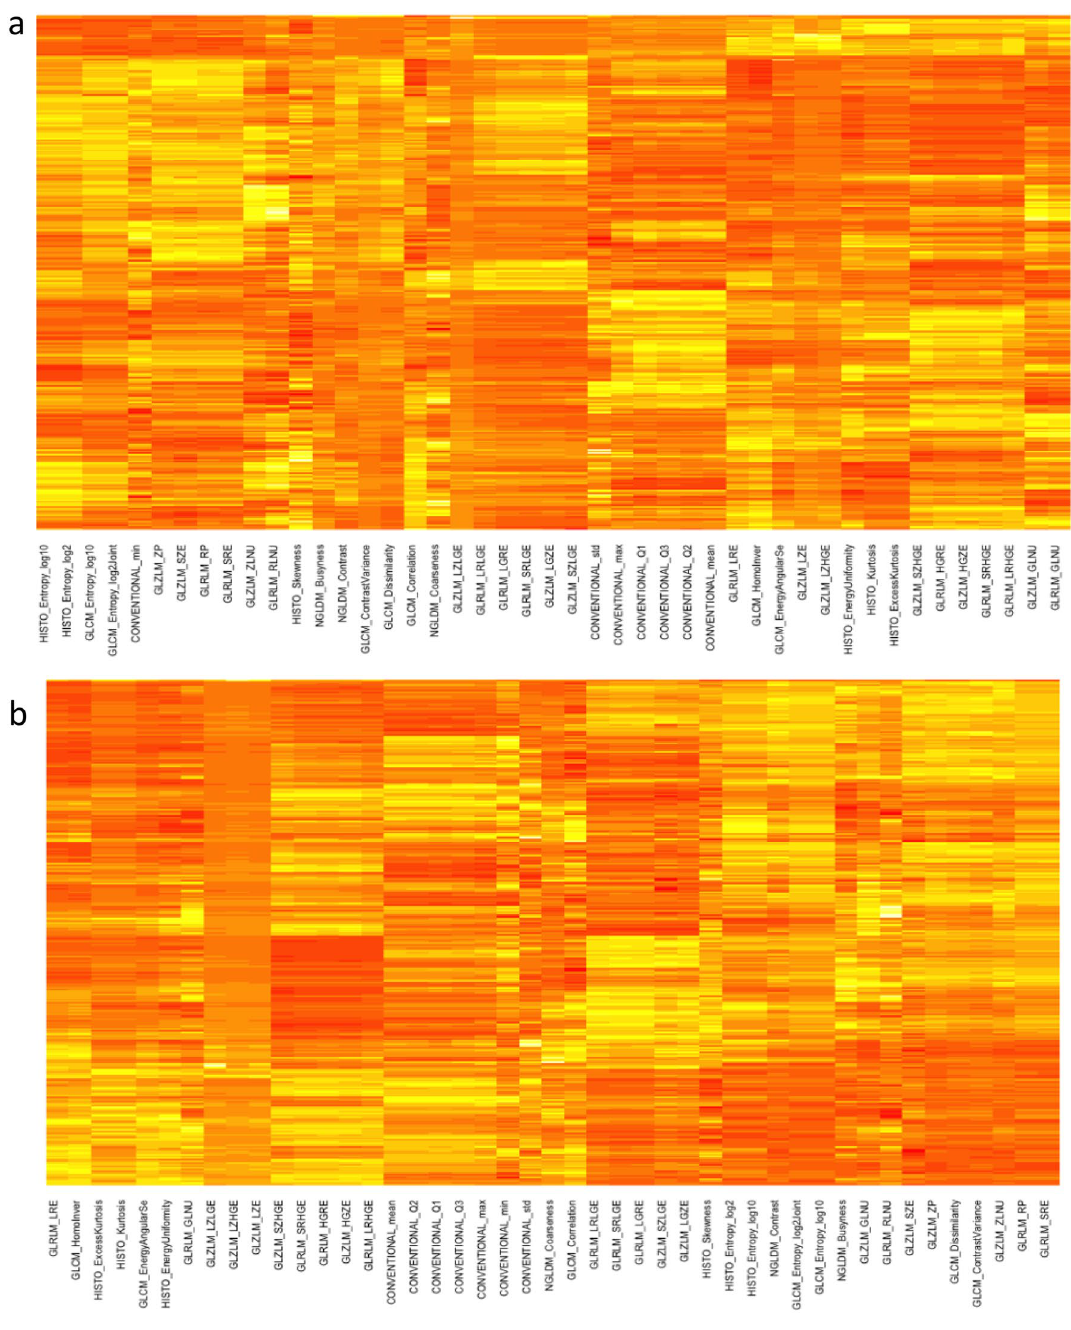
Figure 3. Heat maps generated from 2-dimenensional ( a ) and 3-dimensional ( b ) ROIs segmented in HBP images and demonstrating the distribution of significant features in the study